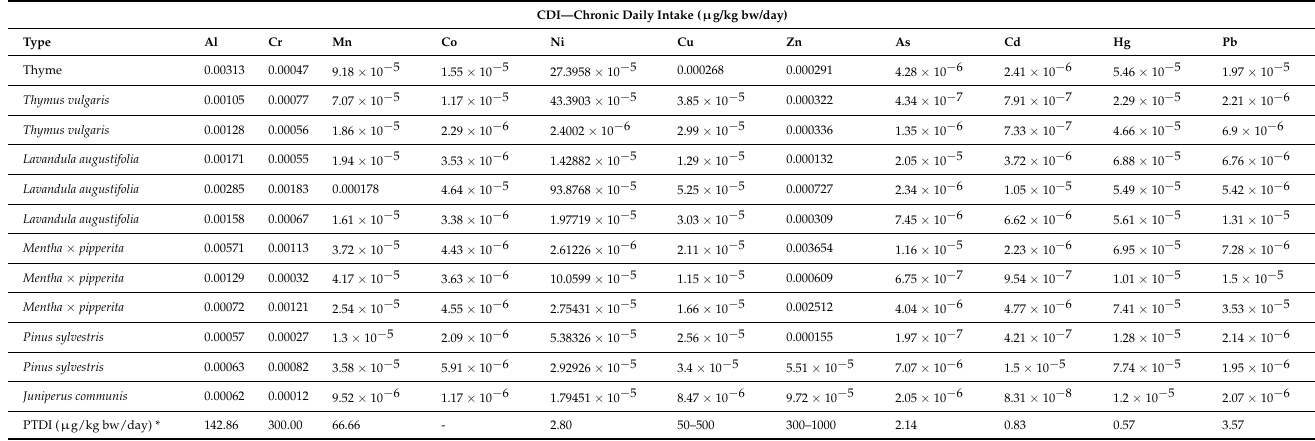
Table 2. The chronic daily intake (CDI) of trace and major elements associated with the essential oil’s ingestion.